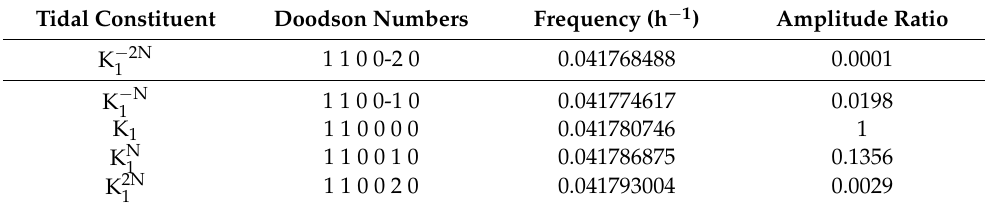
/K 1 and K − N /K 1 are 0.1356 and 0.0198, respectively [32]. 1 1